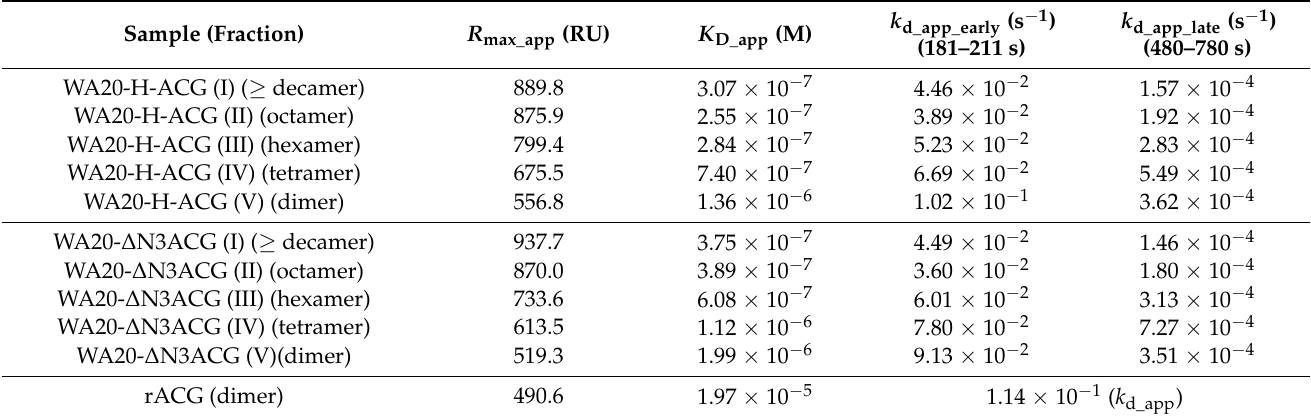
Table 4. Summary of the SPR analysis